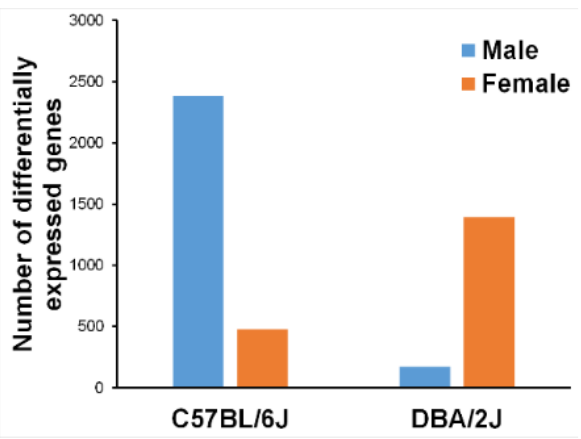
Figure 2. Counts of differentially expressed genes, DE minus air by strain and sex.